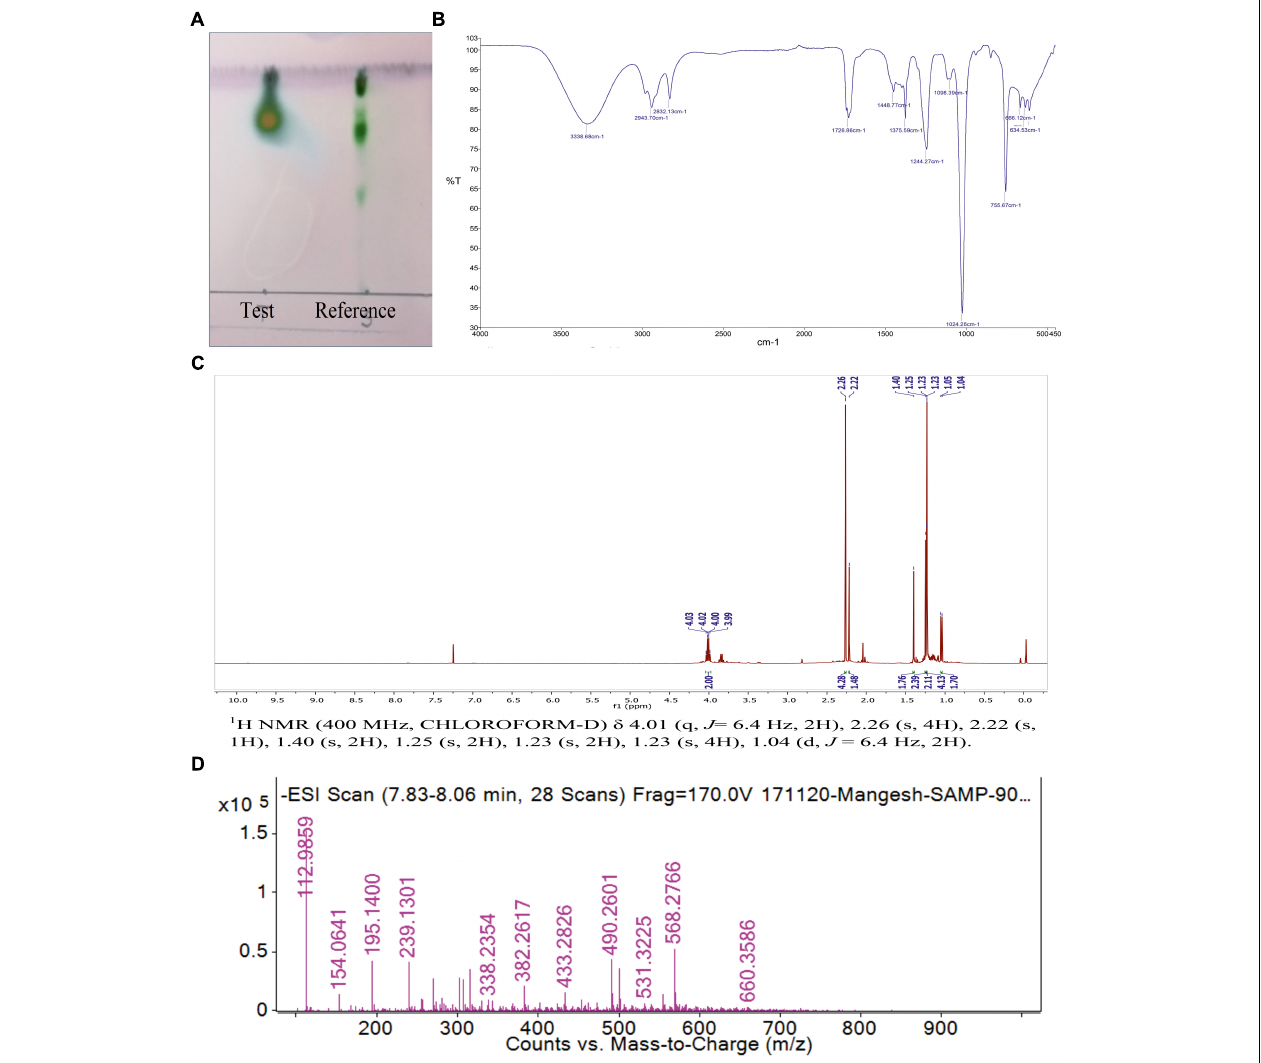
FIGURE 4 | (A) The Thin layer chromatography (TLC) of purified biosurfactant in comparison with reference rhamnolipid. (B) FTIR spectrum of biosurfactant from P. maritimus SAMP. (C) 1 H NMR spectrum of biosurfactant from P. maritimus SAMP. (D) LC-MS spectrum of biosurfactant produced by P. maritimus